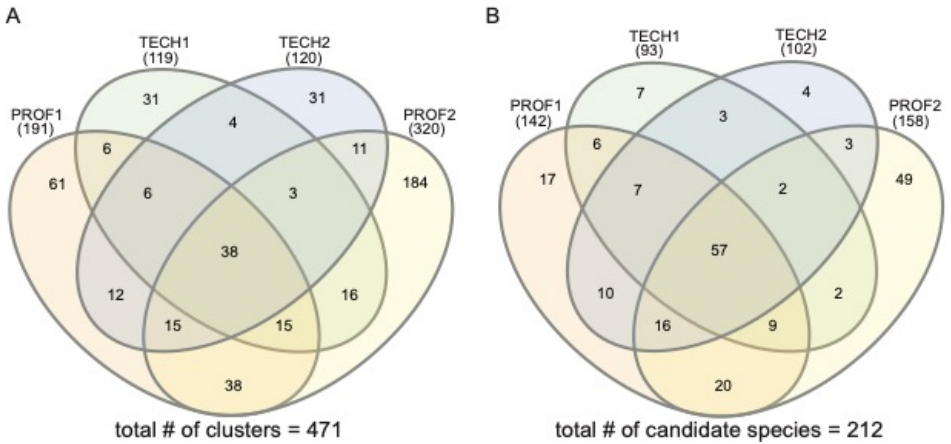
Figure 5. Venn diagrams comparing the four separate samples from the Buckhorn Wash site. ( A ) comparisons of clusters among separate samples; ( B ) Comparisons of candidate species among separate samples. One hundred thirty ‐ five species—ca. 65% of the total species—were shared among two or more samples, but just over 25% were shared among all samples (Figure 5B). The two samples that included the same professional lichenologist shared 102 species. The candidate species that were observed in only a single sample are highlighted in Supple ‐ mentary File S6. Table 2. Taxonomic distribution of genetic clusters and candidate species that were recovered at Buckhorn Wash, Emery County, UT, USA. The proportion of candidate species that was sampled in Buckhorn Wash but was not represented in the BOLD regional DNA reference library (BOLD project LIMW) is reported parenthetically next to the total number of candidate species in each fam ‐ ily. Family